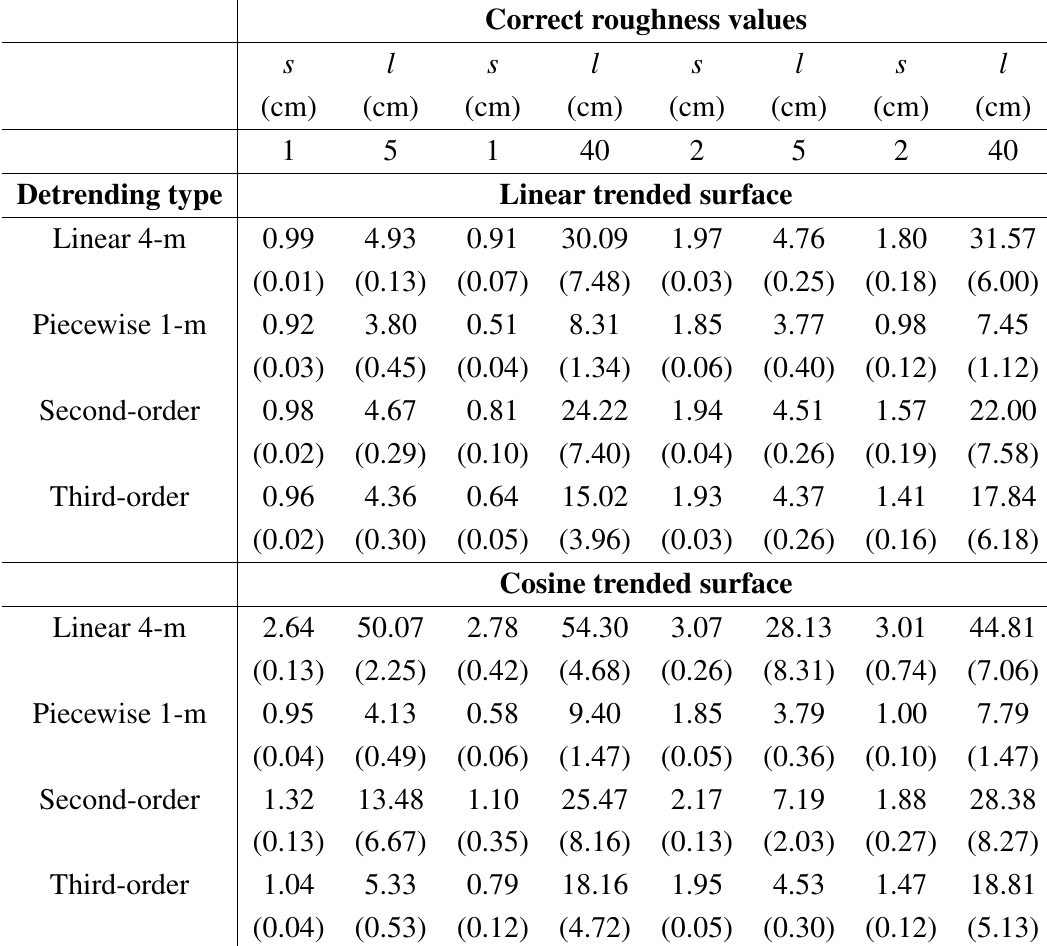
Table 5. Average values of s and l , calculated after detrending of 4-m profiles. Standard deviations are added between